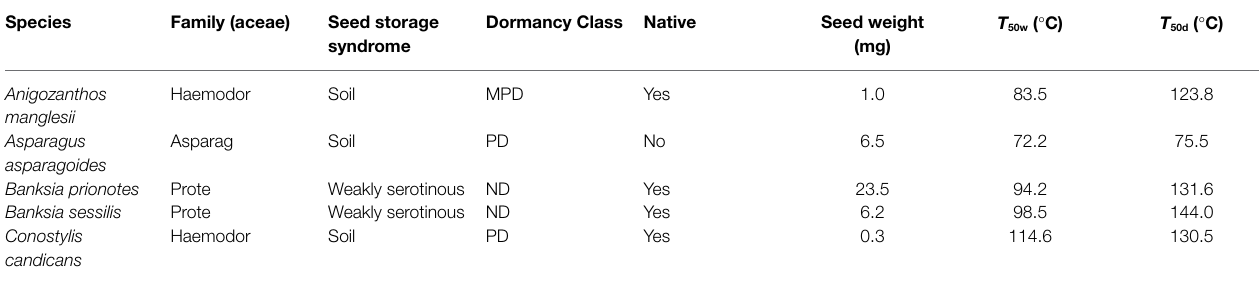
TABLE 1 | Species used for this analysis and their key attributes. Species Family